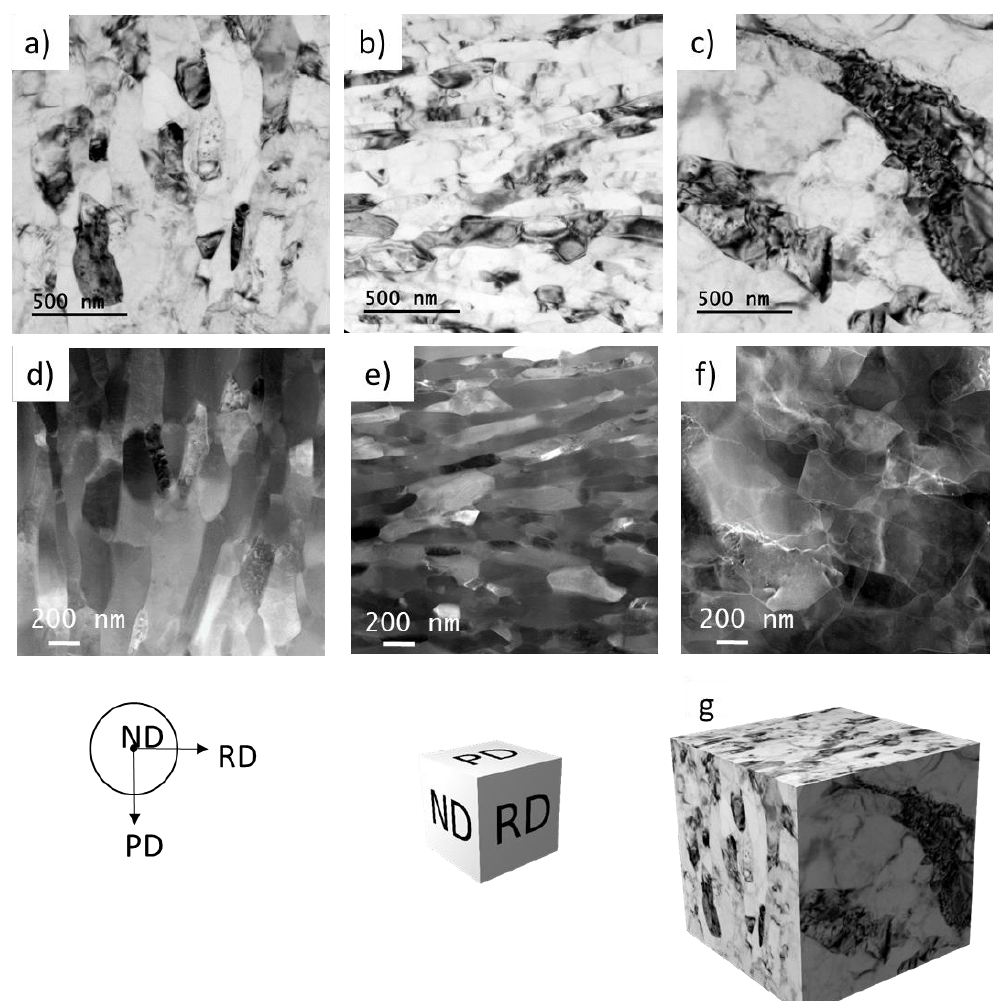
Figure 7. TEM ( a – c ) and STEM ( d – f ) micrographs presenting the microstructure in the middle of the tube wall in per- pendicular directions, on ND ( a , d ), PD ( b , e ), and RD planes ( c , f ) of the tube wall, and 3D reconstruction of the grain structure ( g